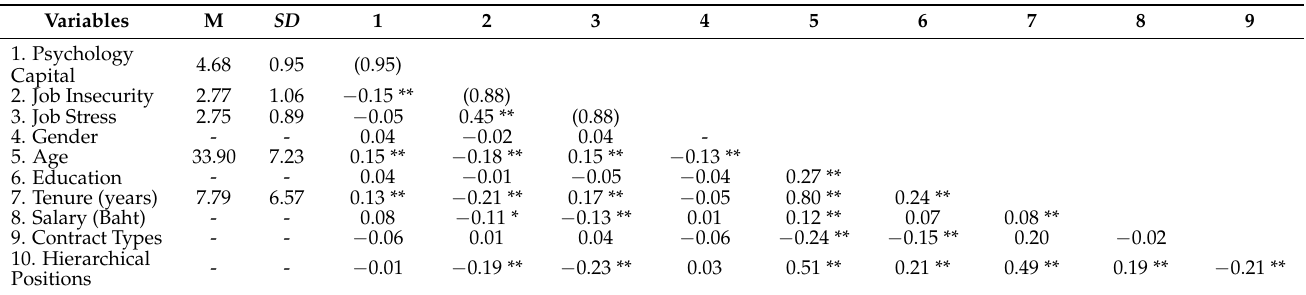
Table 1. Means, standard deviations, and correlations (individual level: N = 520).